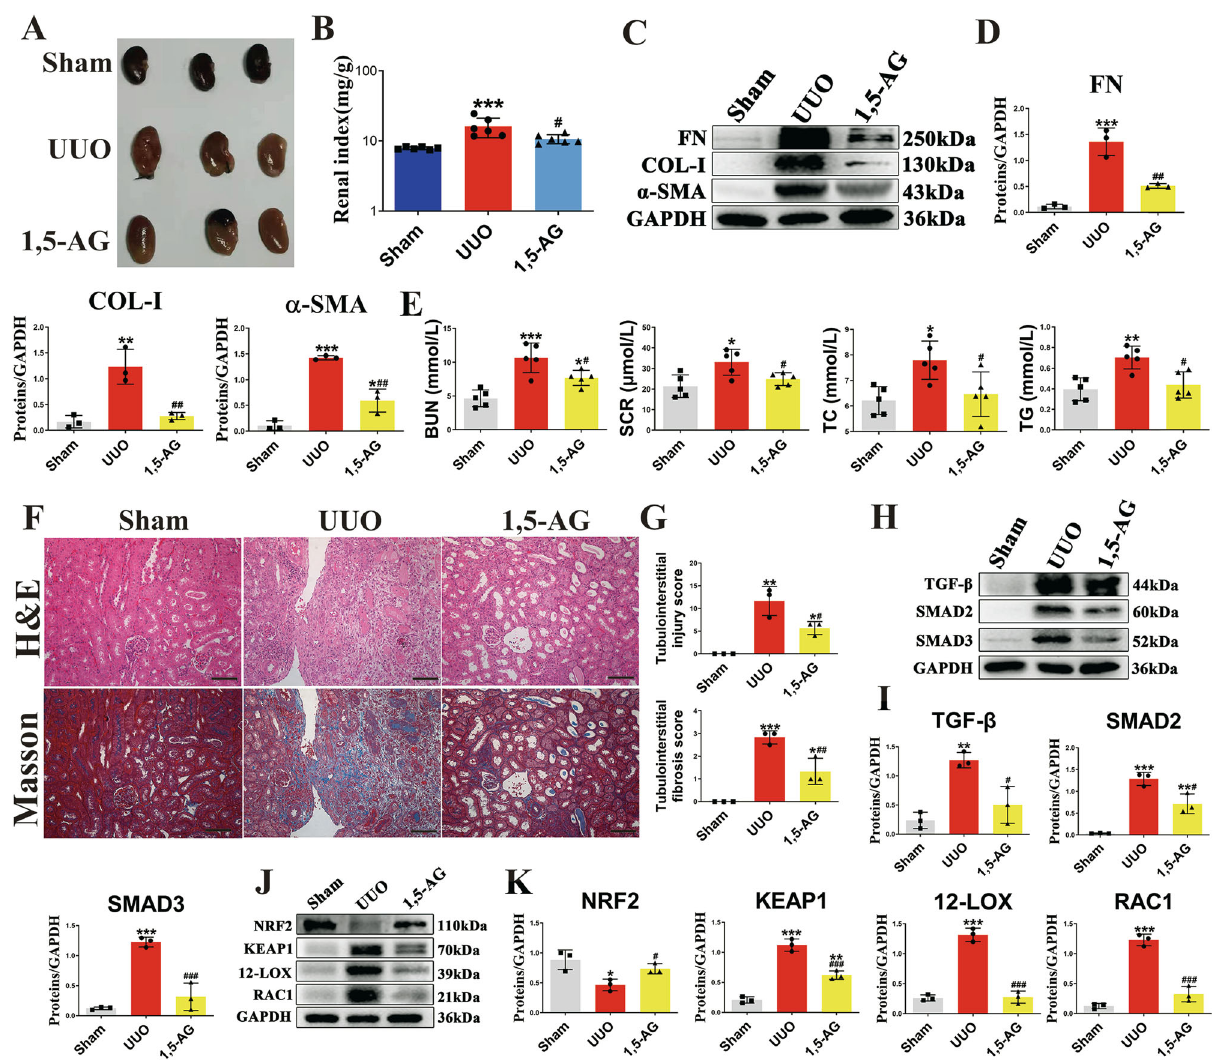
Fig.3|Theanti- fi broticeffectsof1,5-AGinUUOmodel.A Picture ofleftkidneys of mice with different treatments ( n =3). B The renal index (mg/g) ( n =6). *** p =0.0008forB:Shamvs.UUO, p =0.3372forB:Shamvs.1,5-AG, # p =0.0221for B:UUOvs.1,5-AG. C Westernblotsshow fi